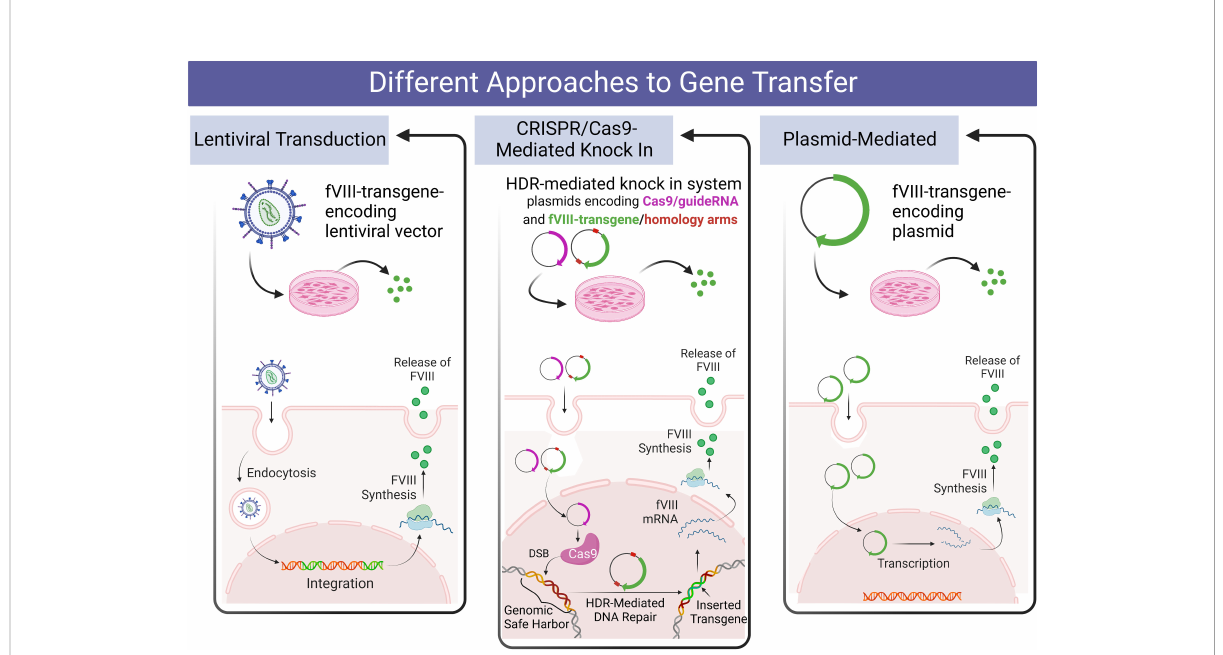
FIGURE 1 Diagrammatic overview of the design of the present studies comparing various methods of delivering a fVIII transgene to human PLCs and